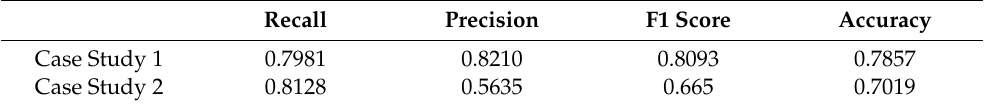
Table 9. Most frequent words using NMF and